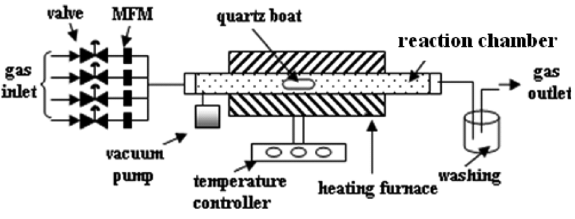
Figure 1: Schematic diagram of CVD reactor.